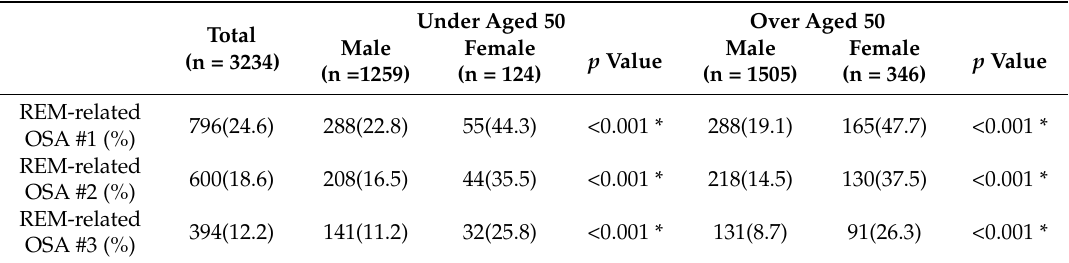
Table 2. Gender difference in the prevalence of REM-related OSA between age-matched groups. Under Aged 50 Over Aged Total (n = 3234)